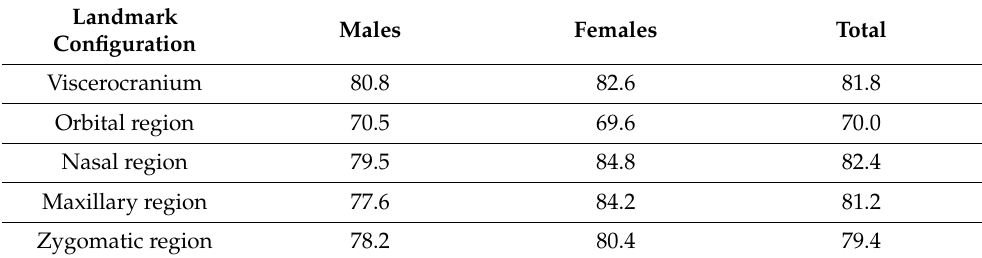
Table 2. Centroid size (in mm) of the configurations in male and female crania.